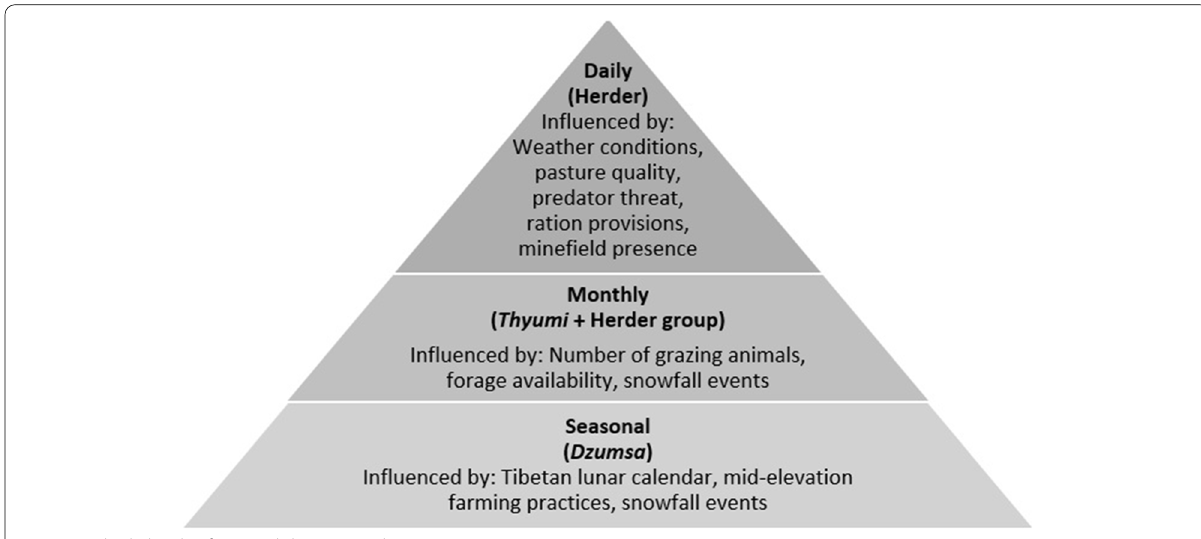
Fig. 2 Multiple levels of pastoral